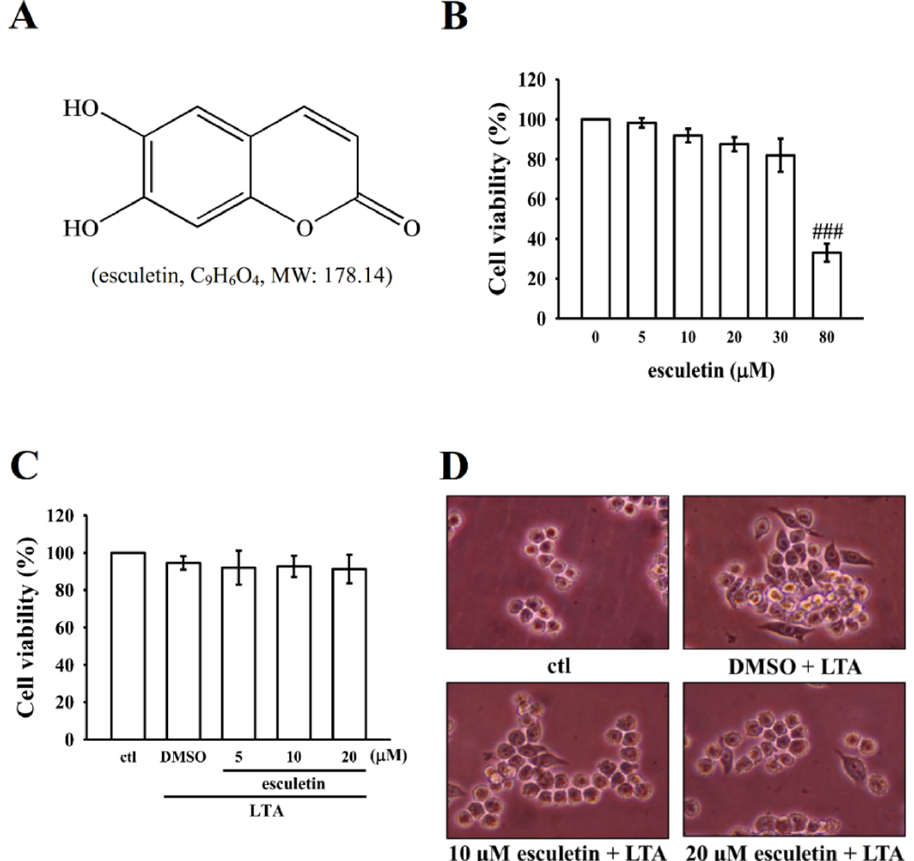
Figure 1. ( A ) The chemical structure of esculetin. 3-(4,5-dimethylthiazol-2-yl)-2,5-diphenyltetrazolium bromide (MTT) cell viability assay of ( B ) esculetin (5–80 µM) alone and ( C ) esculetin pretreated lipoteichoic acid (LTA)-induced RAW 264.7 cells, and ( D ) morphology of esculetin (10 and 20 µM) in LTA-induced RAW cells as described in the Methods section. Data are presented as the means ± standard error (SEM, n = 4); ### p < 0.001 compared with the control group.